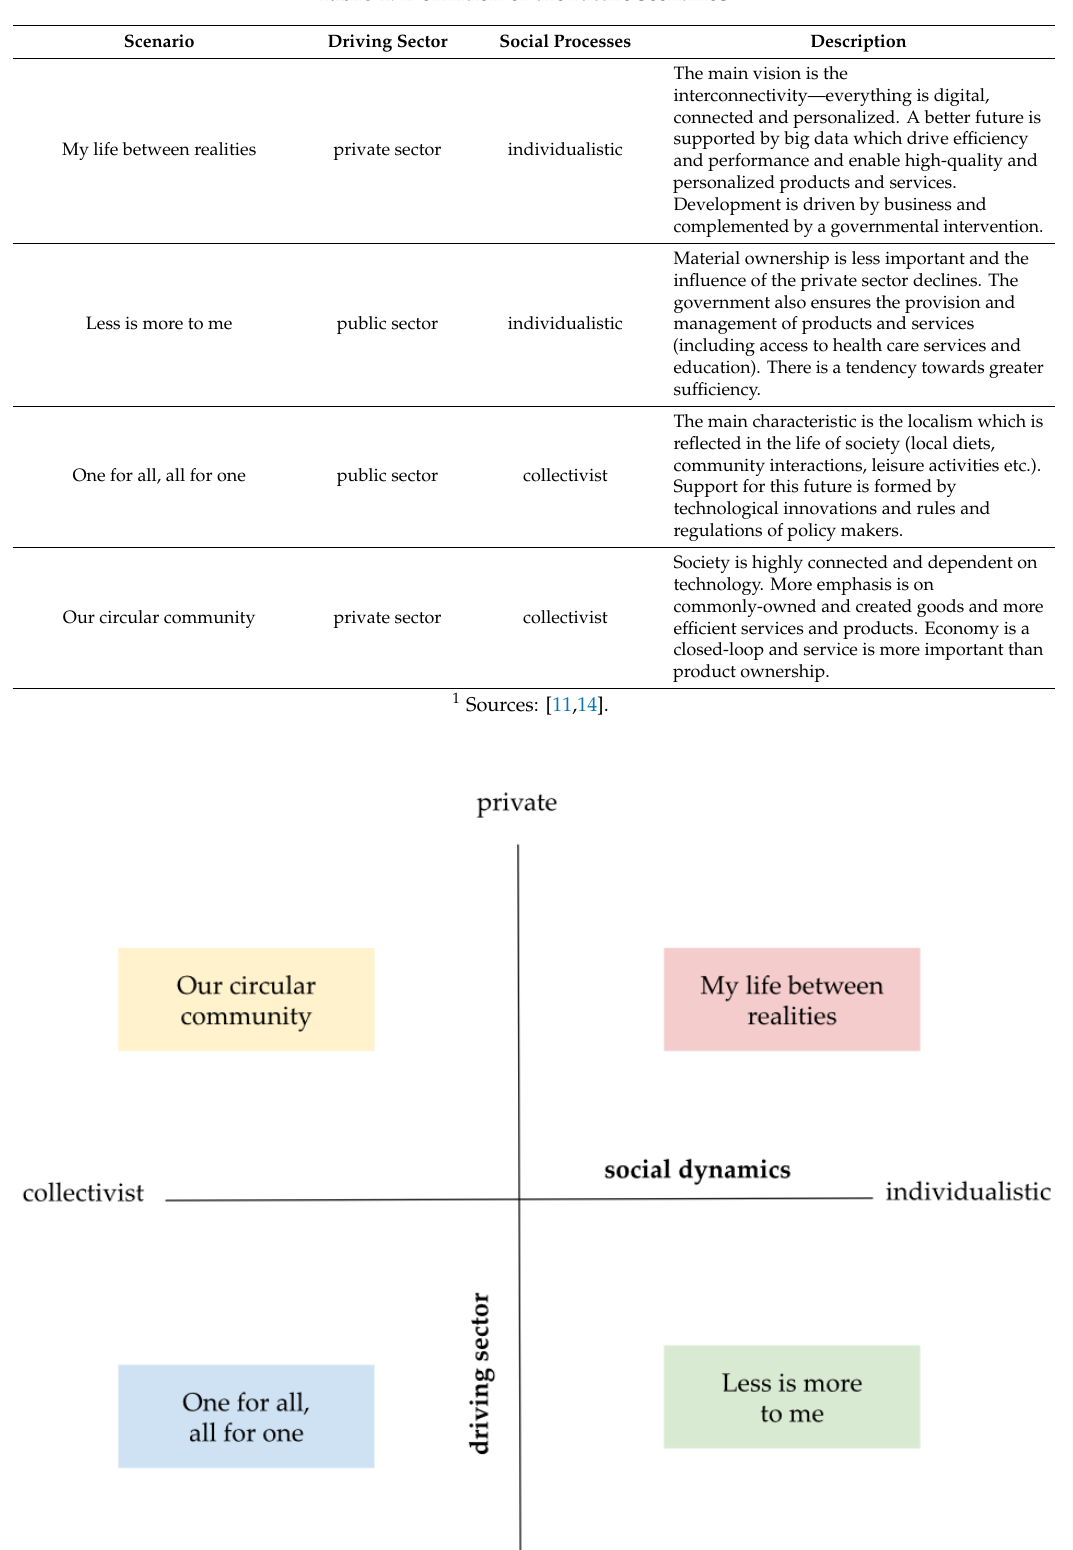
Table 1. Definition of the future scenarios 1 .